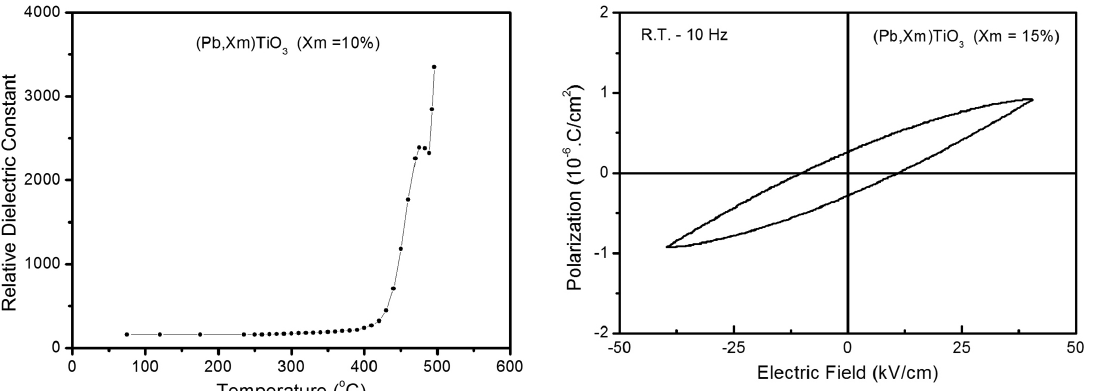
Figure 5. Relative dielectric permittivity as a function of temperature for PXT10 sample sintered at 1150 °C.